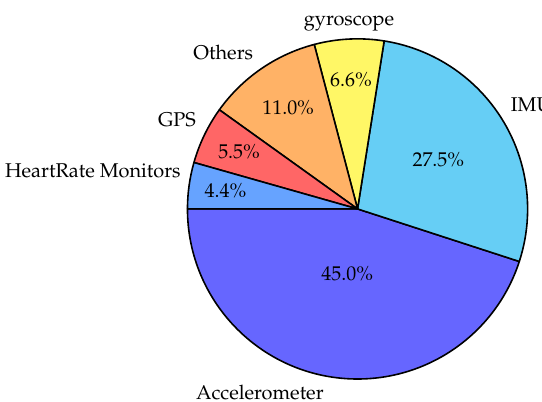
Figure 3. Proportions of the use of each kind of sensor in Free-Living Environments (FLEs) and Semi-Free-Living Environments (semi-FLEs).